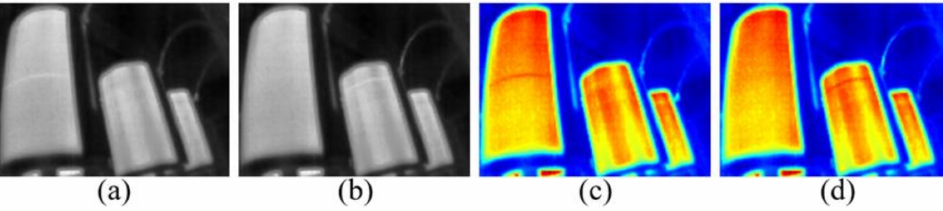
Figure 18. The tested thermal image. ( a , b ) In grayscale, ( c , d ) in color, all using untrained fault traces.